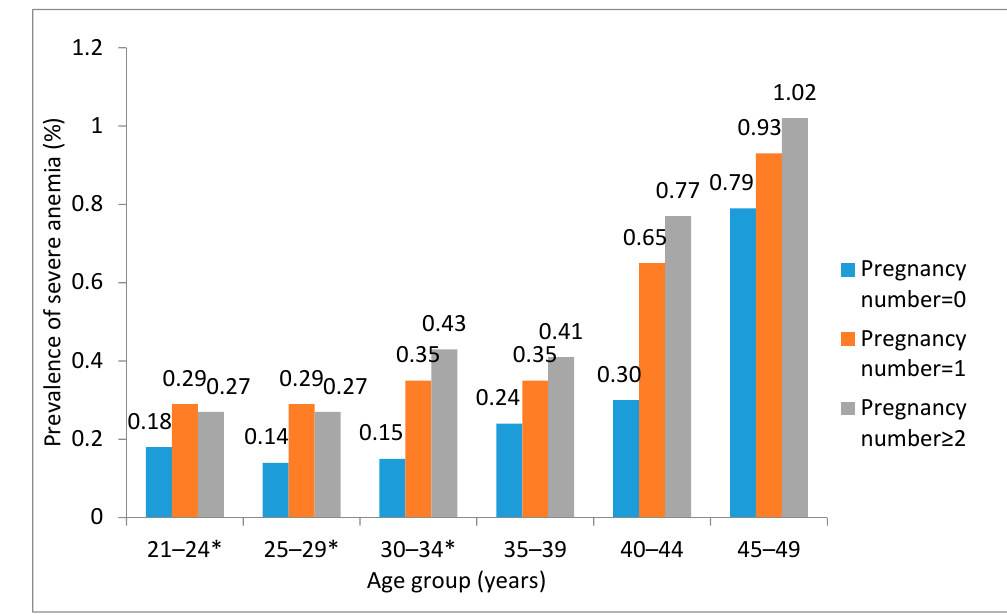
Figure 2. Age-specific prevalence rates of severe anemia in women with different pregnancy numbers in 2012, rural China. * The age group with significant difference in severe anemia prevalence in different pregnancy numbers.